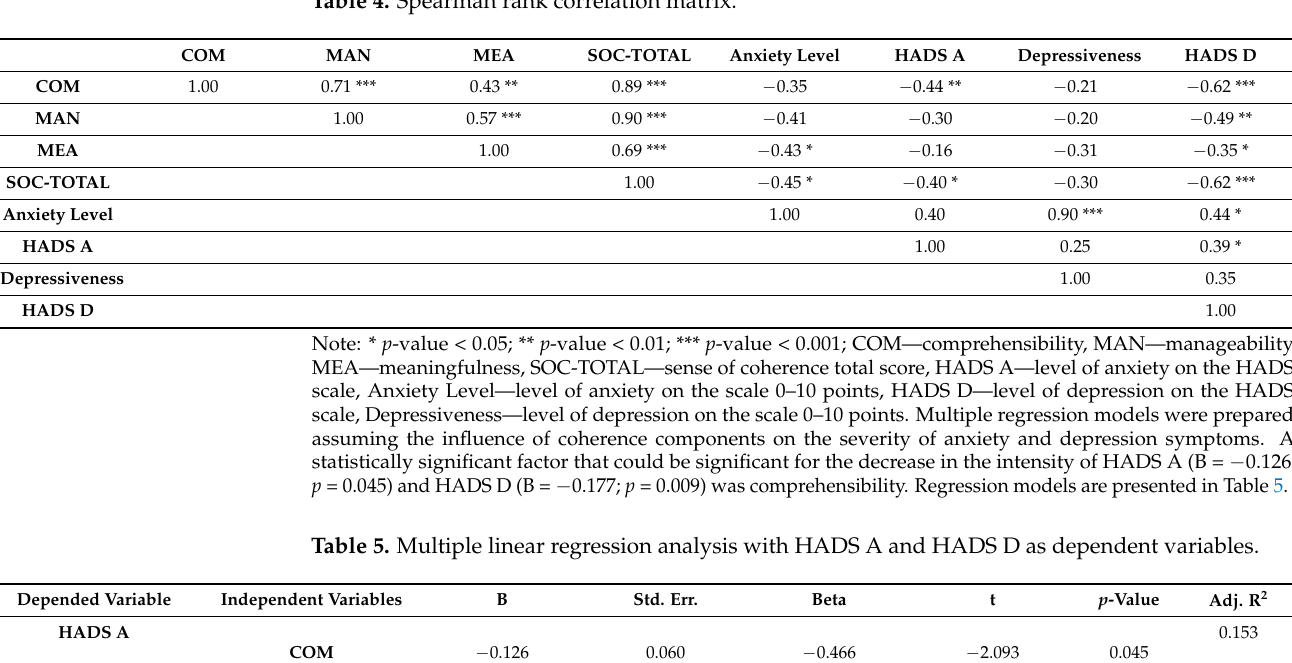
Table 4. Spearman rank correlation matrix.